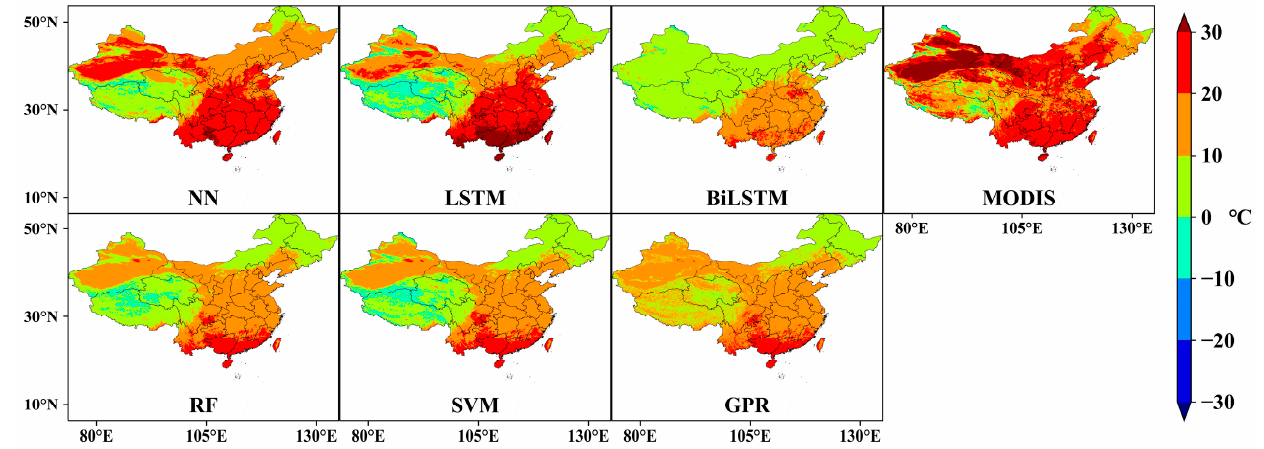
Figure 9. The NLSAT estimation results for the spring of 2015.